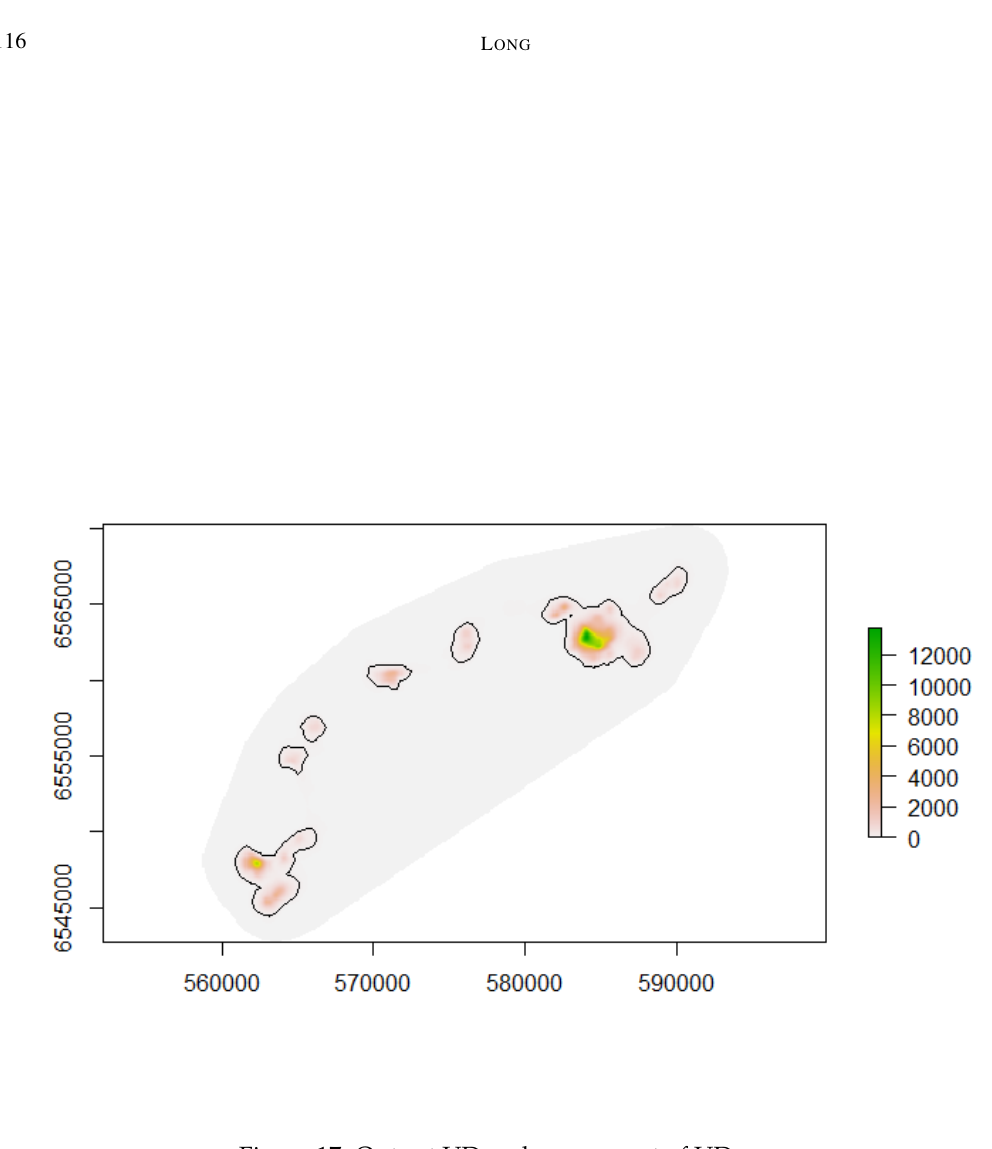
Figure 17: Output UD and square root of